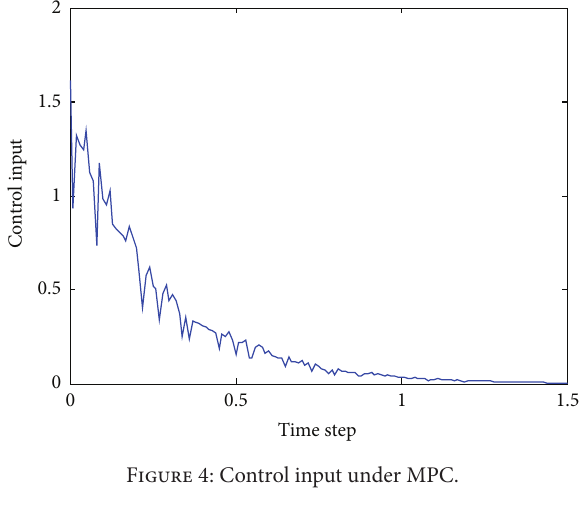
Figure 4: Control input under MPC.